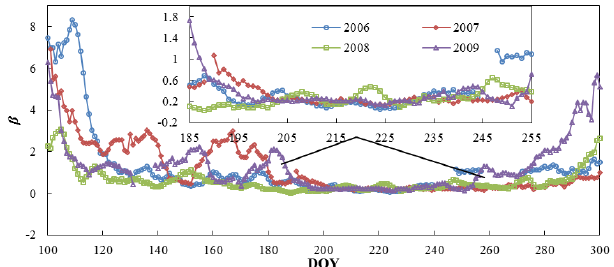
Figure 4. Seasonal and inter-annual variability of the midday (10:00–15:00LST) mean Bowen ratio ( β ; 5-day running average) across the growing seasons, with detailed β during DOY 185–255 represented in the small